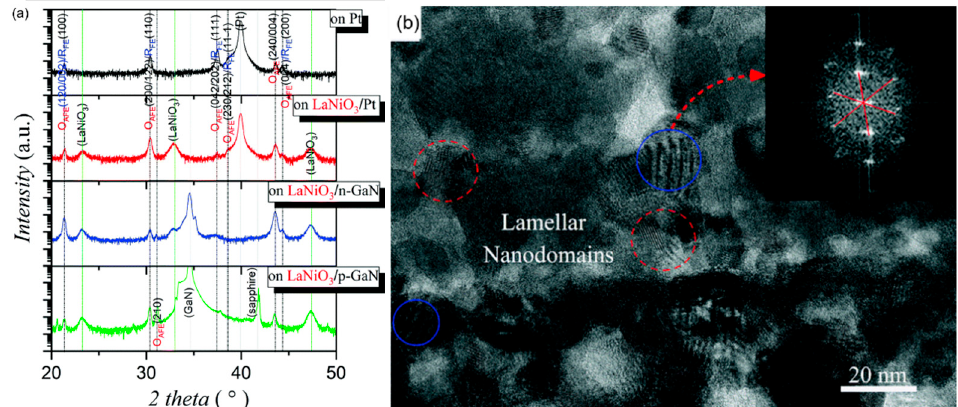
Figure 29. ( a ) XRD patterns of Pb 0.78 Ba 0.2 La 0.02 ZrO 3 (PBLZ) thin films on Pt, LaNiO 3 /Pt, LaNiO 3 /p- GaN and LaNiO 3 /n-GaN substrates. FE: ferroelectric, AFE: antiferroelectric, O: orthorhombic and R: rhombohedral. ( b ) Cross-sectional TEM image of the thin film on the LaNiO 3 /Pt substrate. Inset: The fast Fourier transform spectrum of the HRTEM image of the nanodomains with a blue circle as guided by the red arrow. Reprinted with permission from [106]. Copyright 2019 The Royal Society of Chemistry. sol-gel method and obtained a positive electrocaloric ( EC ) effect at 10 kHz ( ∆ T ~ 12.3 K, ∆